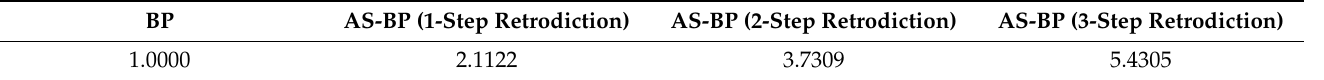
Table 2. Relative computation time for the fully connected